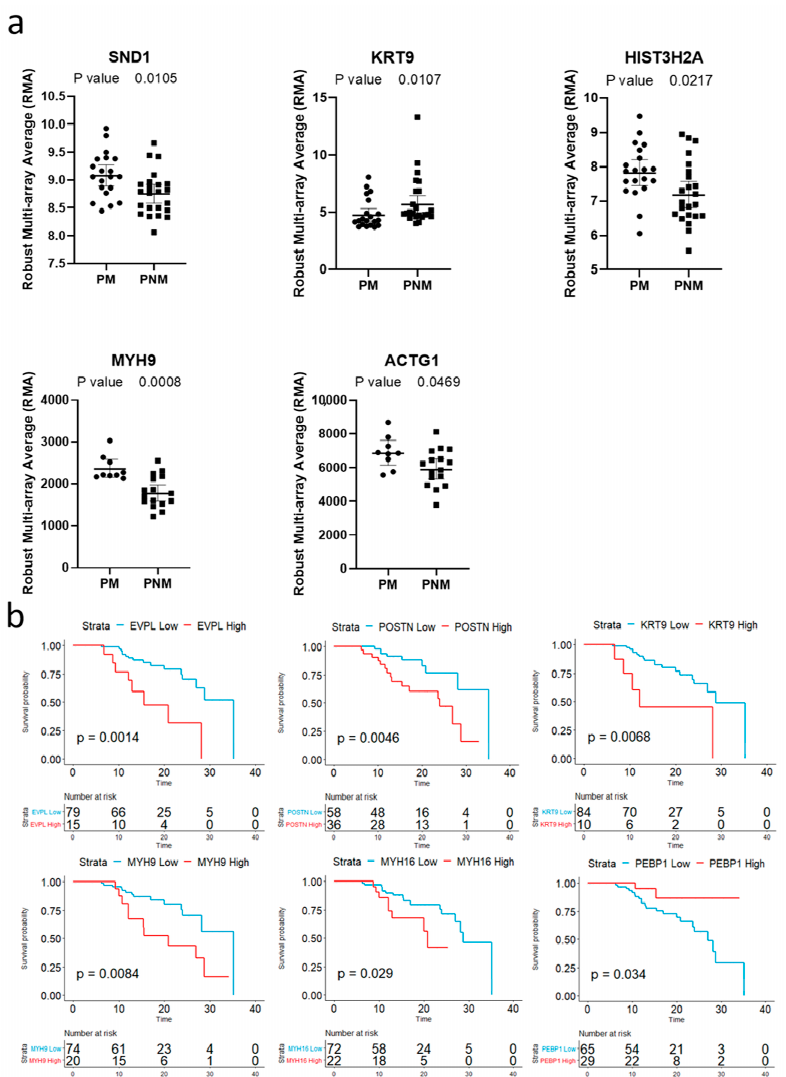
Figure 3. Validation of di ff erentially expressed proteins using two NCBI GEO datasets and TCGA survival analysis. ( a ) Primary melanoma samples which could be inferred as either P-M or P-NM from GEO datasets; GSE15605 and GSE46517, were analysed separately for the 16 di ff erentially expressed proteins identified via mass spectrometry. Median with interquartile range shown as error bars. ( b ) Survival analysis of cutaneous melanoma data from TCGA indicated that genes encoding for 6 proteins that were significantly di ff erentially between P-M and P-NM have a significant e ff ect on 3-year survival in patients with cutaneous